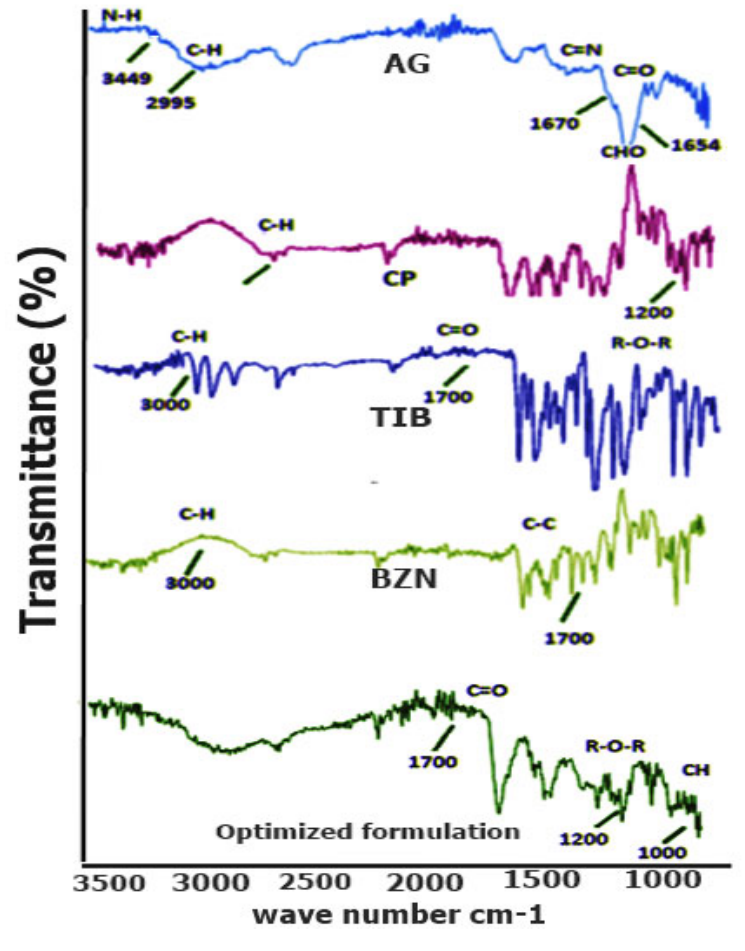
Figure 5. FTIR of AG, CP, TIB, BZN and of the physical mixture according to optimized formula ‐ tion.